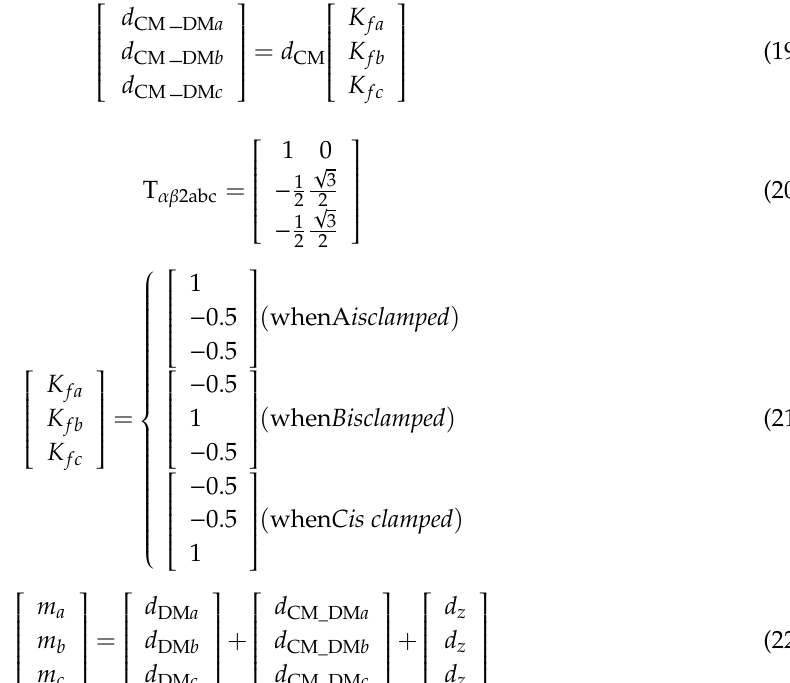
16 kHz Table 3. Model number of devices used in the experiment. Device